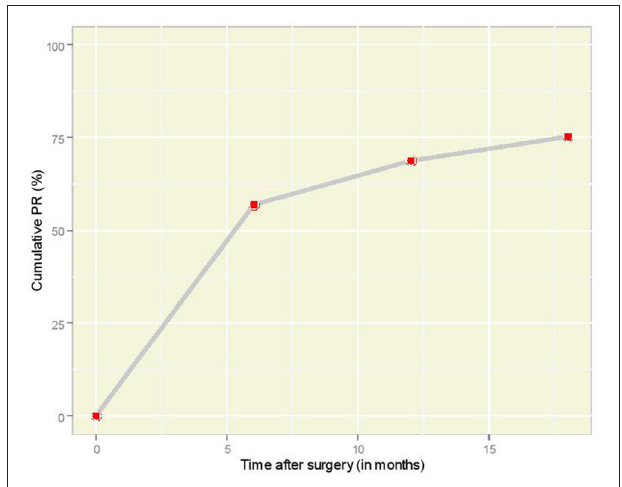
FIGURE 1 | Overall cumulative PR plot according to time interval (in months) after laparoscopic anastomosis.